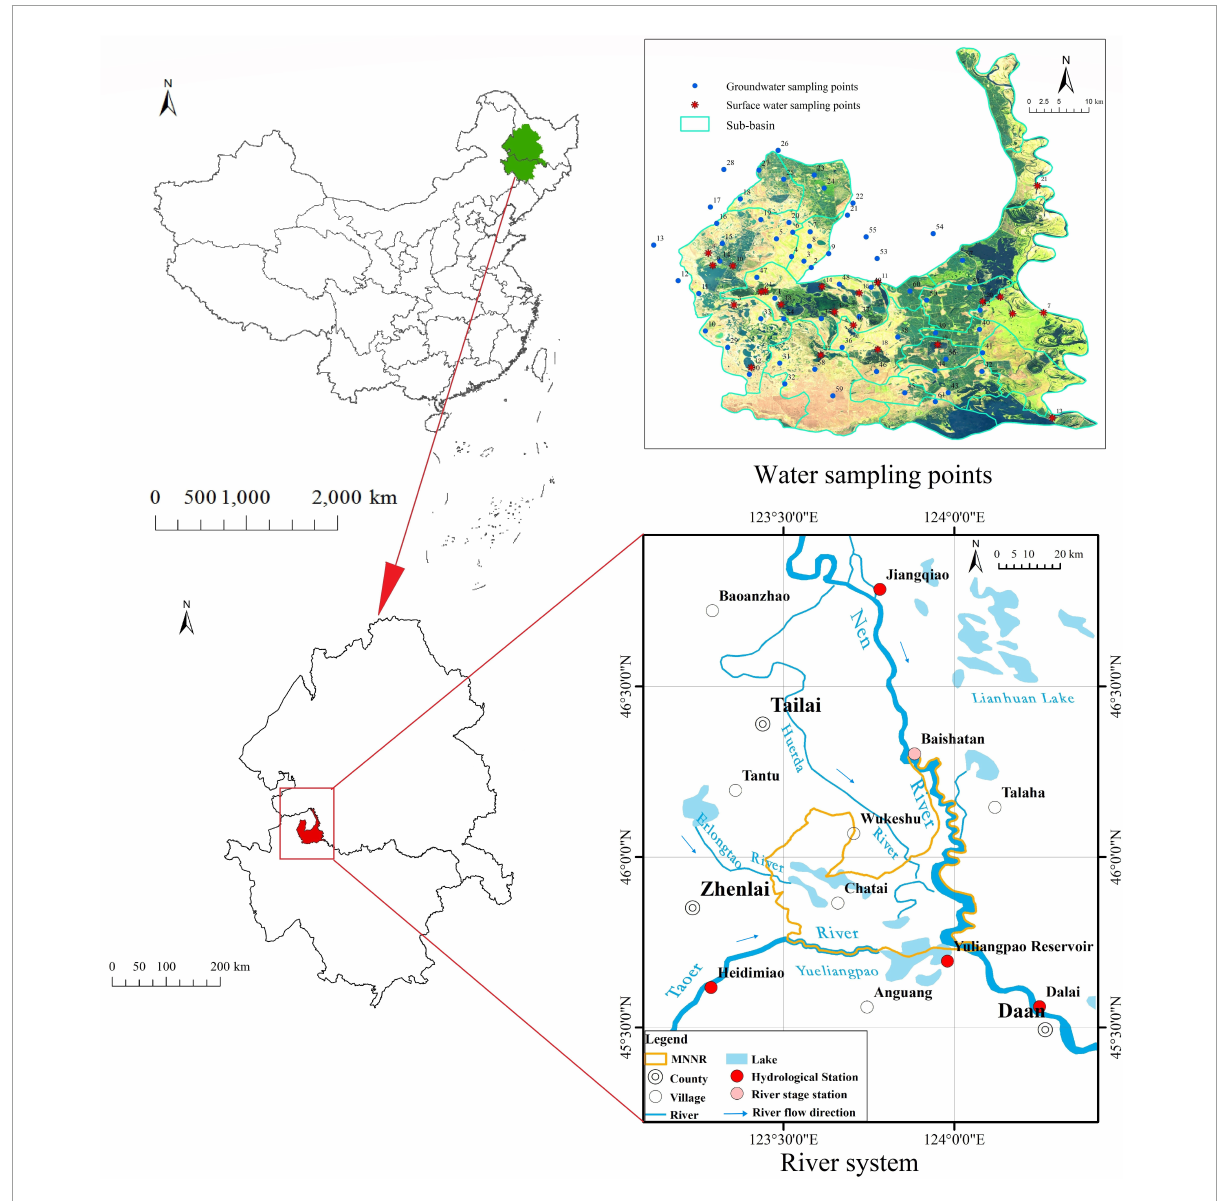
FIGURE1 Location of the study area and distribution of sampling points.